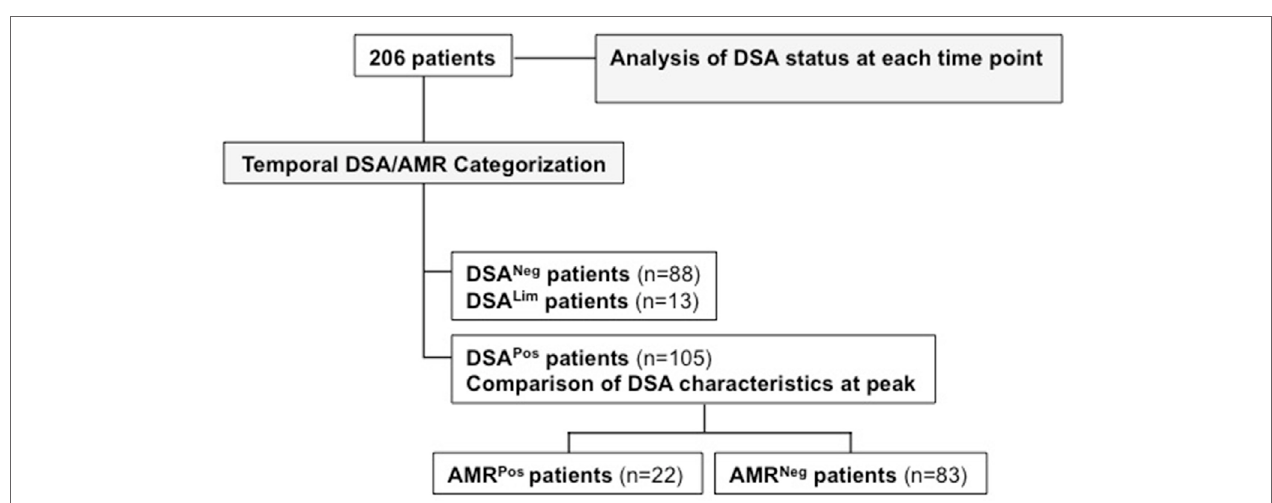
FigUre 1 | Flow chart and analysis summary.